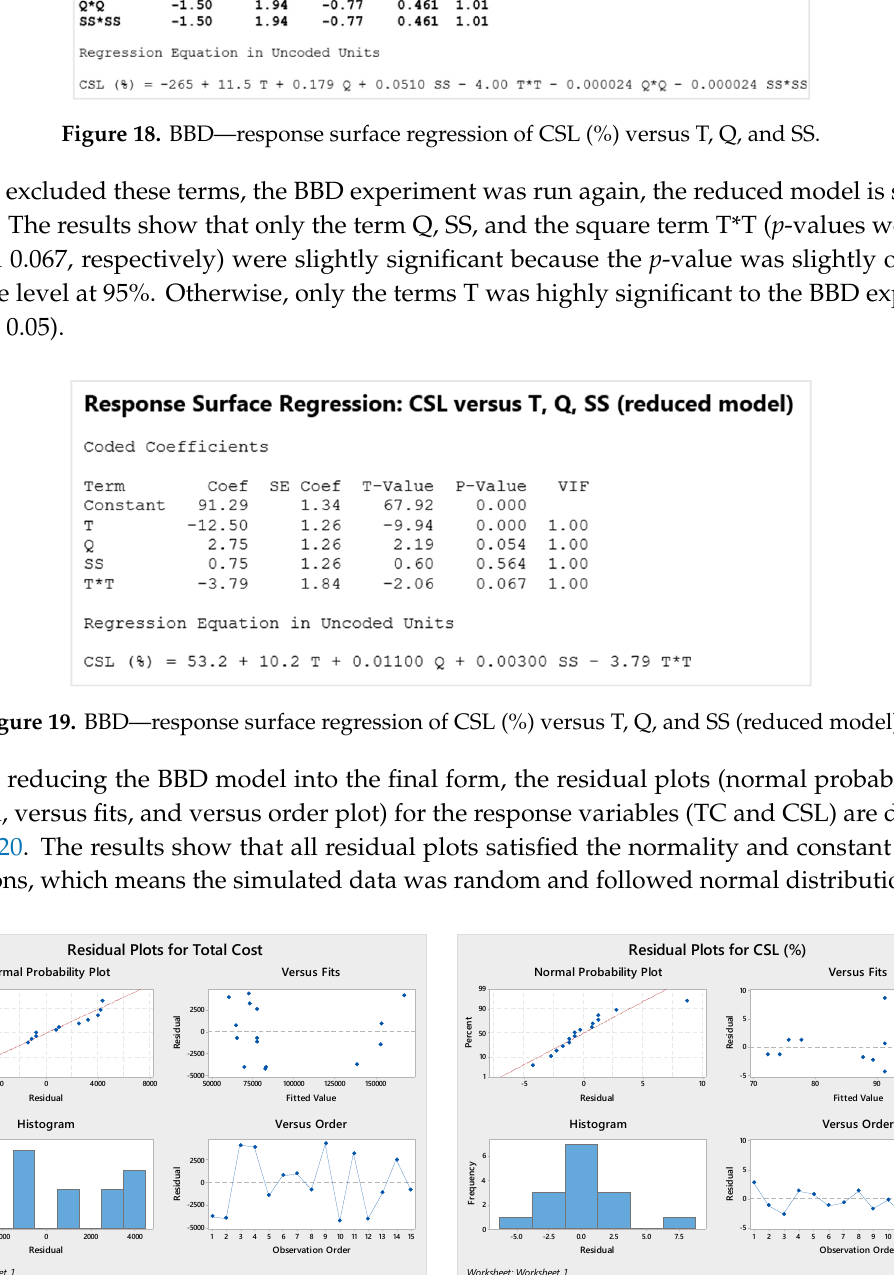
( a ) Residual plots for TC ( b ) Residual plots for CSL (%) Figure 20. BBD—residual plots for TC and CSL.